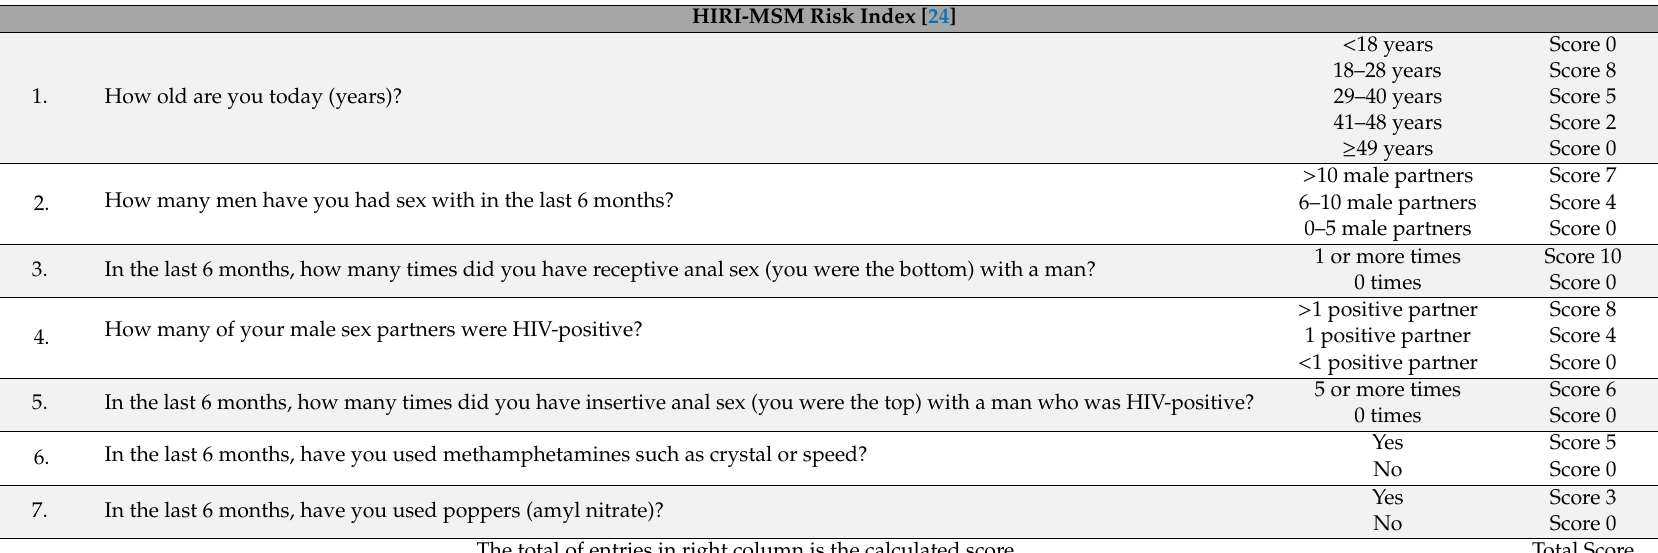
Table 1. Seven-item CDC HIV incidence risk index for MSM